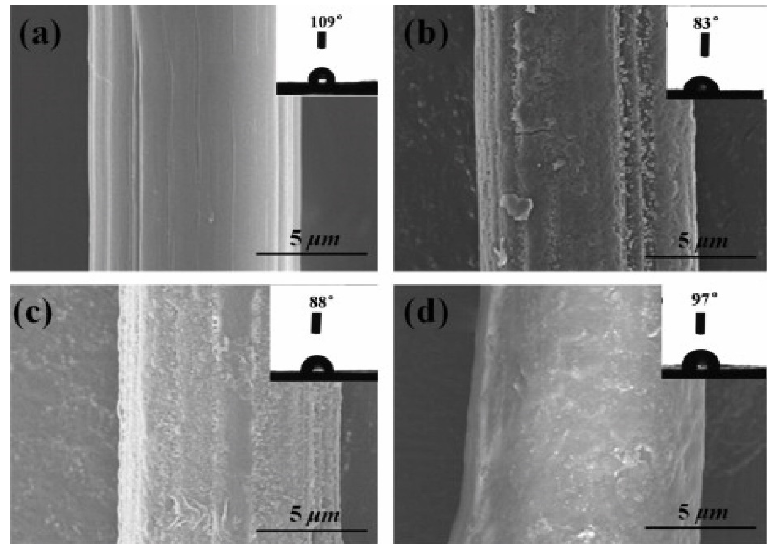
Figure 2. SEM images for ( a ) pristine UHMWPE fibers; ( b ) UHMWPE-PDA fibers; ( c ) UHMWPE- PDA-EDGE fibers; ( d ) UHMWPE– (PDA + EGDE) fibers; and micrographs of the water contact angle test. Reprinted with permission from [41].